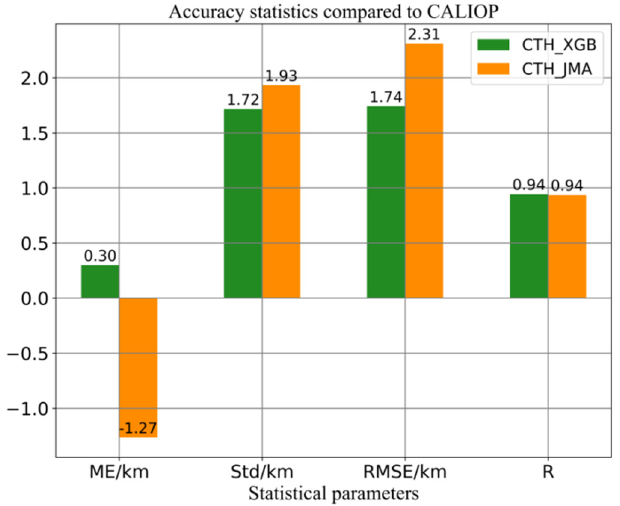
Figure 8. Statistical results compared with CTH CAL .